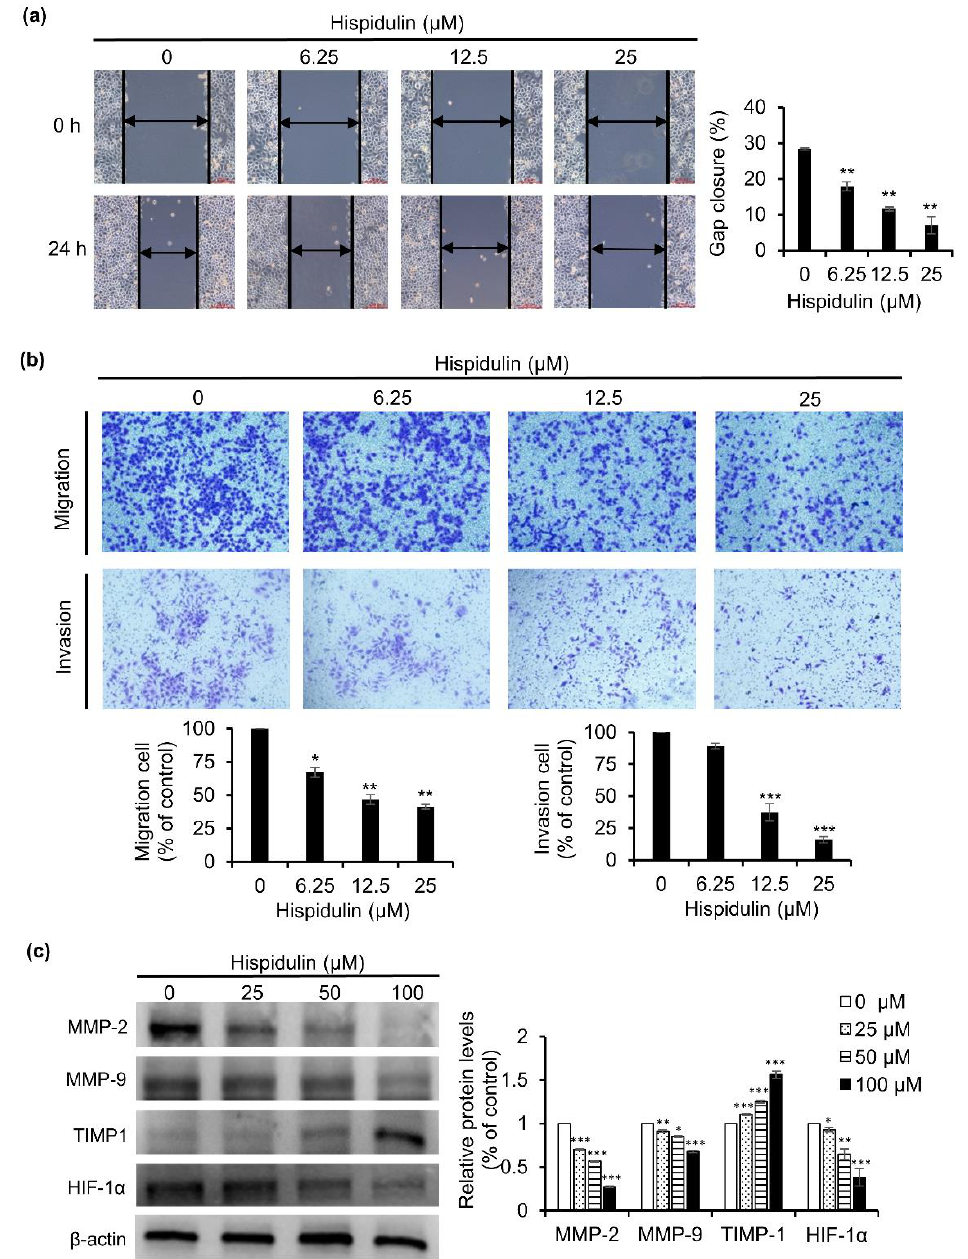
Figure 4. Hispidulin suppressed CNE-2Z cell migration and invasion. CNE-2Z cells were treated with various concentration of hispidulin for the indicated times. ( a , b ) Scratch wound and transwell invasion assays were performed to detect the migration and invasive abilities of CNE-2Z cells. ( c ) Western blot detected the expression of HIF-1α, MMP-2, MMP-9, and TIMP1. * p < 0.05, ** p < 0.01, *** p < 0.001 vs. control.